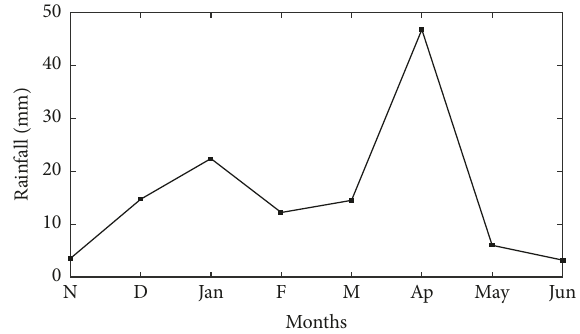
Figure 1: Monthly changes of rainfall in the study